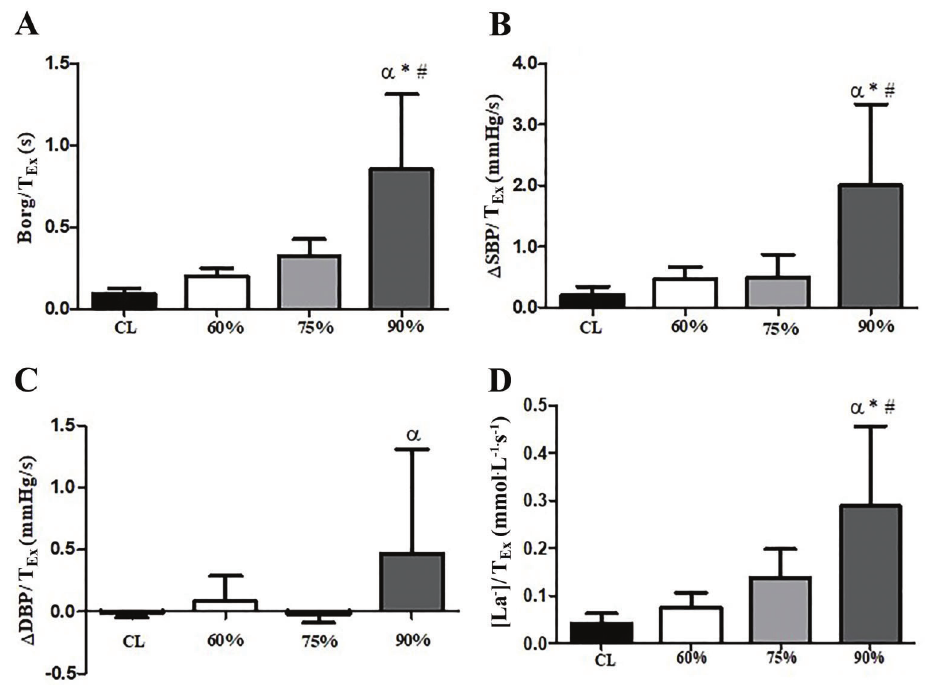
Figure 4. Peak Borg scale corrected to time to exhaustion (T Ex ) ( A ), variation of systolic blood pressure ( D SBP) corrected to T Ex ( B ), variation of diastolic blood pressure ( D DBP) corrected to T Ex ( C ), and lactate ([La-]) corrected to T Ex ( D ) responses at different intensities as well as on critical load (CL). Data are reported means ± SD. SBP. a P o 0.05 compared to CL; *P o 0.05 compared to 60%; # P o 0.05 compared 75%